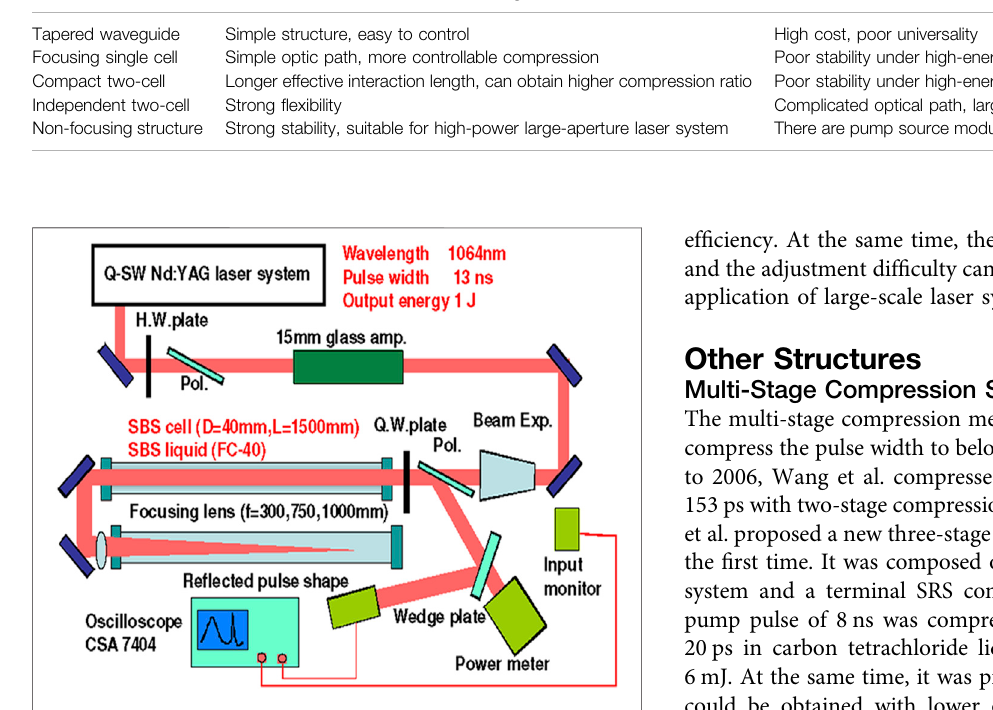
FIGURE6| Schematicdiagramoftypicalexperimentdesignofcompact two-cell [84].